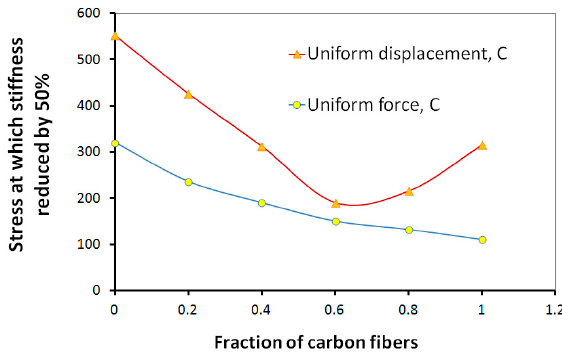
Figure 9. Critical stress (corresponding to D = 50%) plotted versus the fraction of carbon fibers in hybrid glass/carbon fiber composites (from [57], with kind permission of Elsevier).